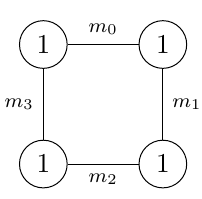
Figure 19 . Mass-deformed b A 3 extended quiver. For ~k = (1 ; (cid:0) 1 ; 1 ; (cid:0) 1) the associated Chern-Simons theory is the gauge theoretical realization of the M-crystal model with four